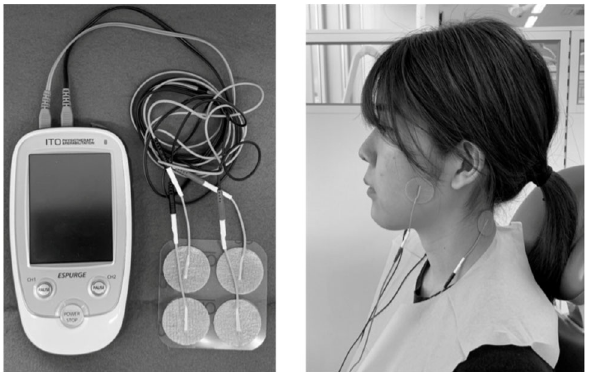
Figure 1. The transcutaneous electric nerve stimulation (TENS) device and its application on the masticatory muscles. (Figure from [83], https://pubmed.ncbi.nlm.nih.gov/33081336/#&gid=article ‐ figures&pid=figure ‐ 1 ‐ uid ‐ 0 accessed on 18 November 2022).